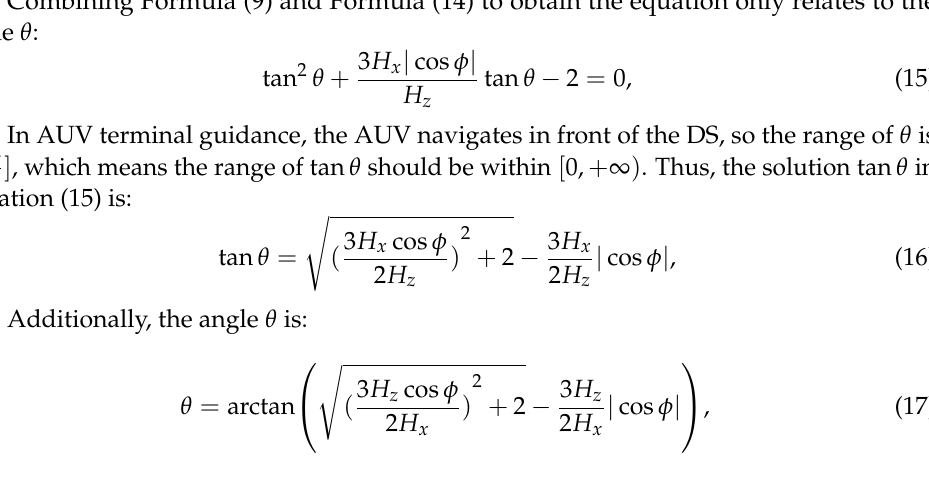
In the near field, the magnetic field intensity in every direction is in-phase or anti- phase with the current of the transmitting coil. Therefore, the magnetic field intensity in every direction is also in-phase or anti-phase with each other. According to Formula (9), √ . H x is in-phase if point P is located within the area for which θ < arctan 2 = θ m ≈ 54.7 ◦ , with the coil current. The distribution of a magnetic field vector of a point in front of the transmitting coil where the x-coordinate is negative is shown in Figure 3. Suppose that, at this time, the magnetic line in the figure converges to the transmitting coil so the magnetic . . . H x , H y and H z . The vector points to the positive end field vector can be decomposed into of its axis, which means that it is in-phase with the current in the transmitting coil.